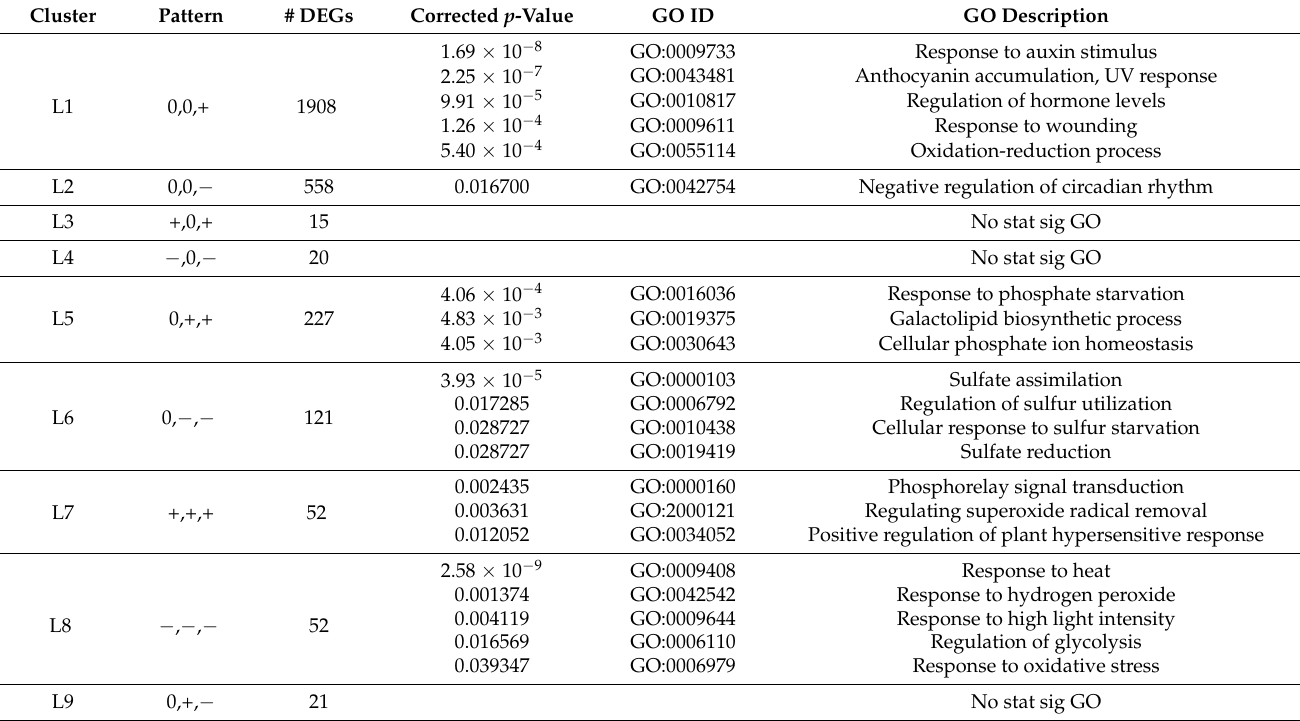
Cluster corresponds to list designation in Figure 2. Pattern reflects the gene expression pattern in -Fe-Fe, -P i -P i , and -Fe-P i samples: 0 indicates no significant change in expression, + indicates upregulated expression, − indicates downregulated expression. # DEGs indicates the number of differentially expressed genes assigned to each cluster. Corrected p -value is calculated using a Fisher’s exact test with a Bonferroni correction. Short horizontal lines separate information for multiple GO terms assigned to the same